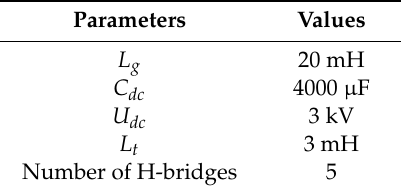
Table 5. The parameters of the power flow controller (PFC).